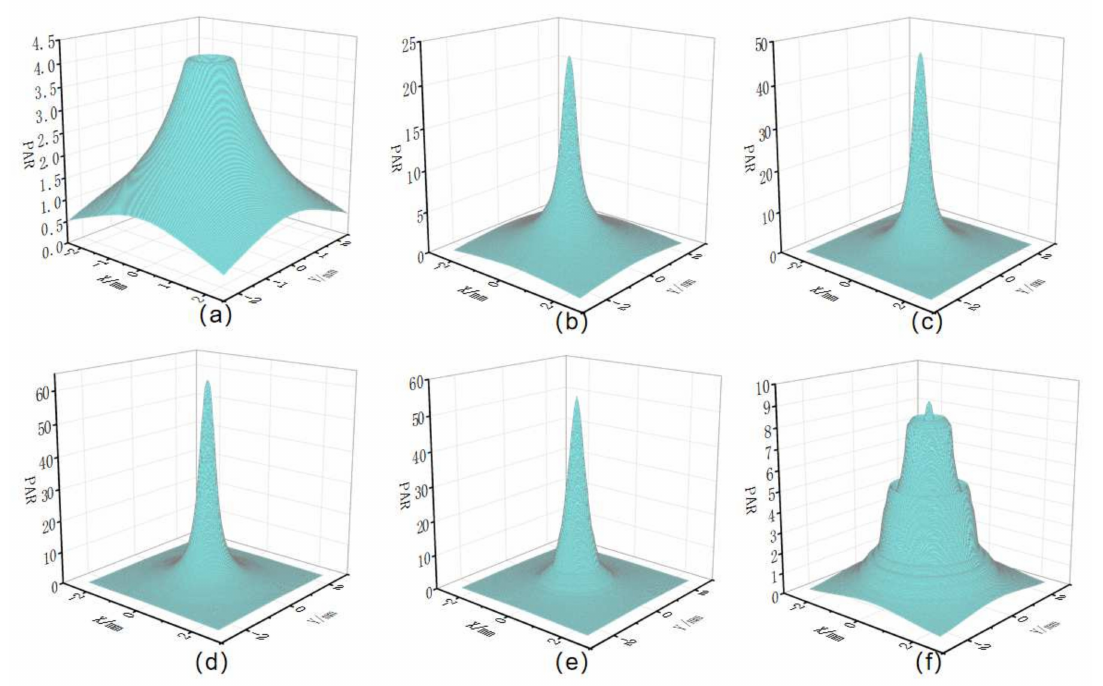
Figure 5. Light spot distribution on the cell surface. ( a ) Z = 108 mm; ( b ) Z = 109 mm; ( c ) Z = 110 mm (focal plane); ( d ) Z = 111 mm; ( e ) Z = 112 mm; ( f ) Z = 114